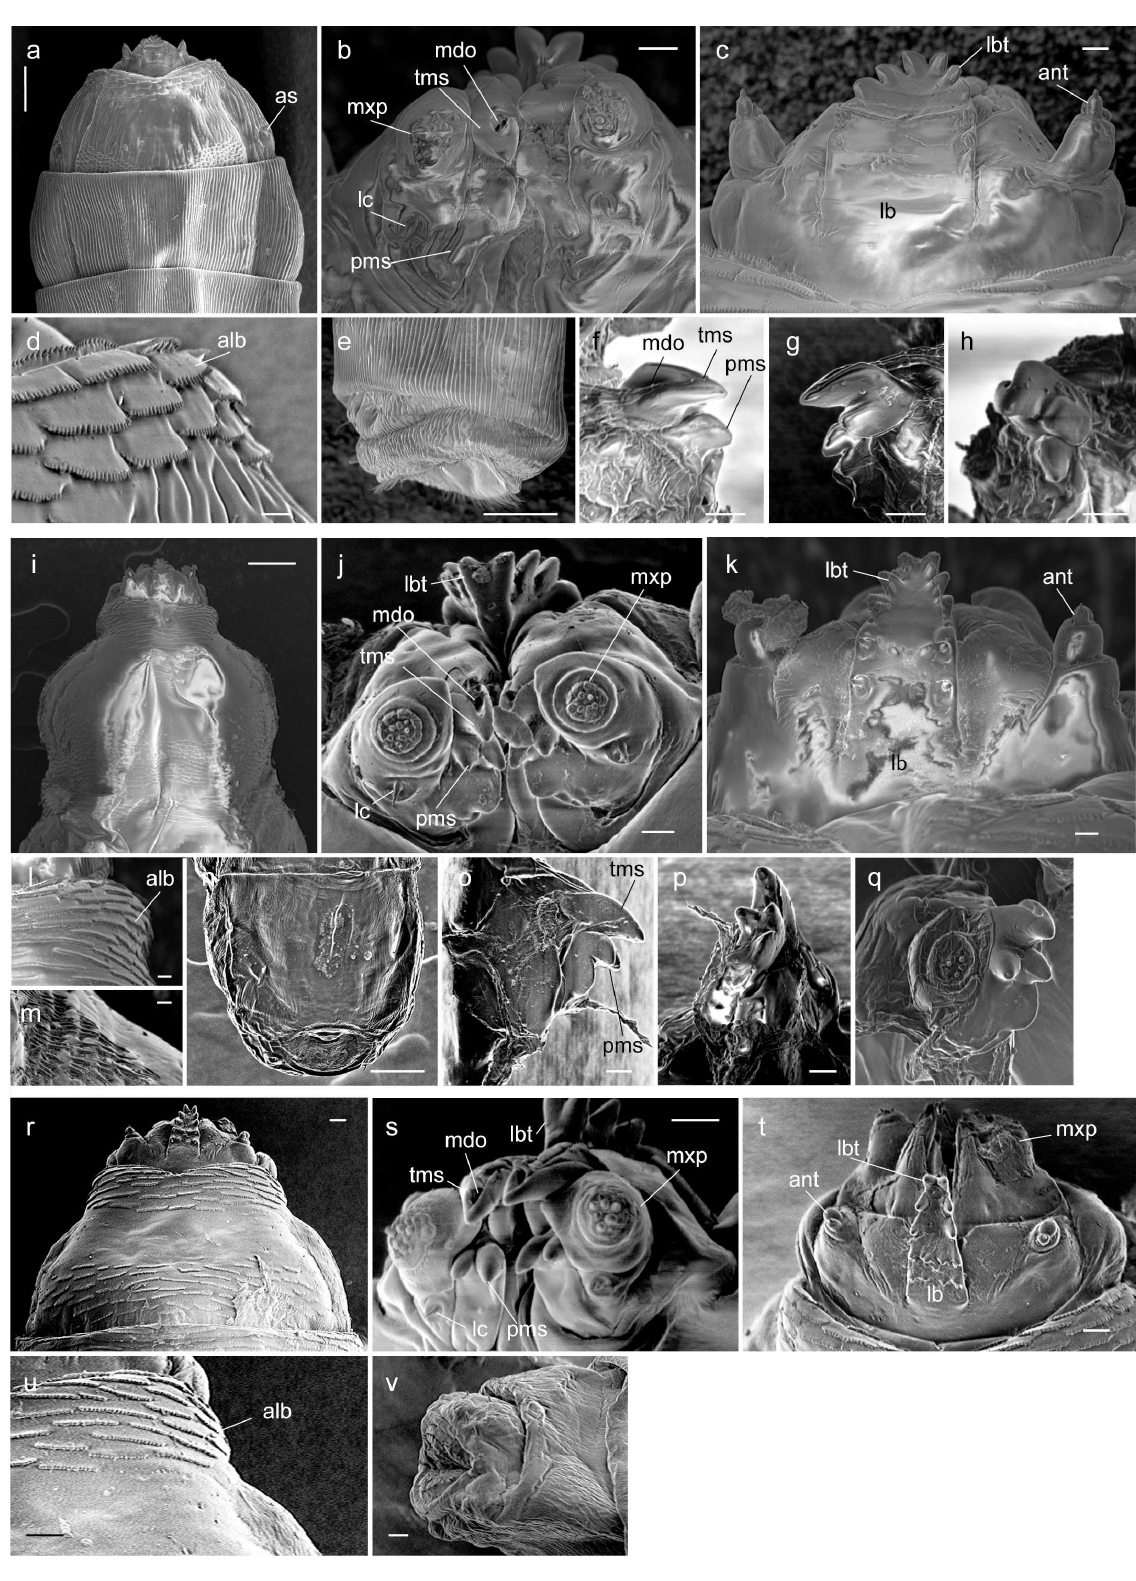
PLOS ONE | DOI:10.1371/journal.pone.0165808 November 3,